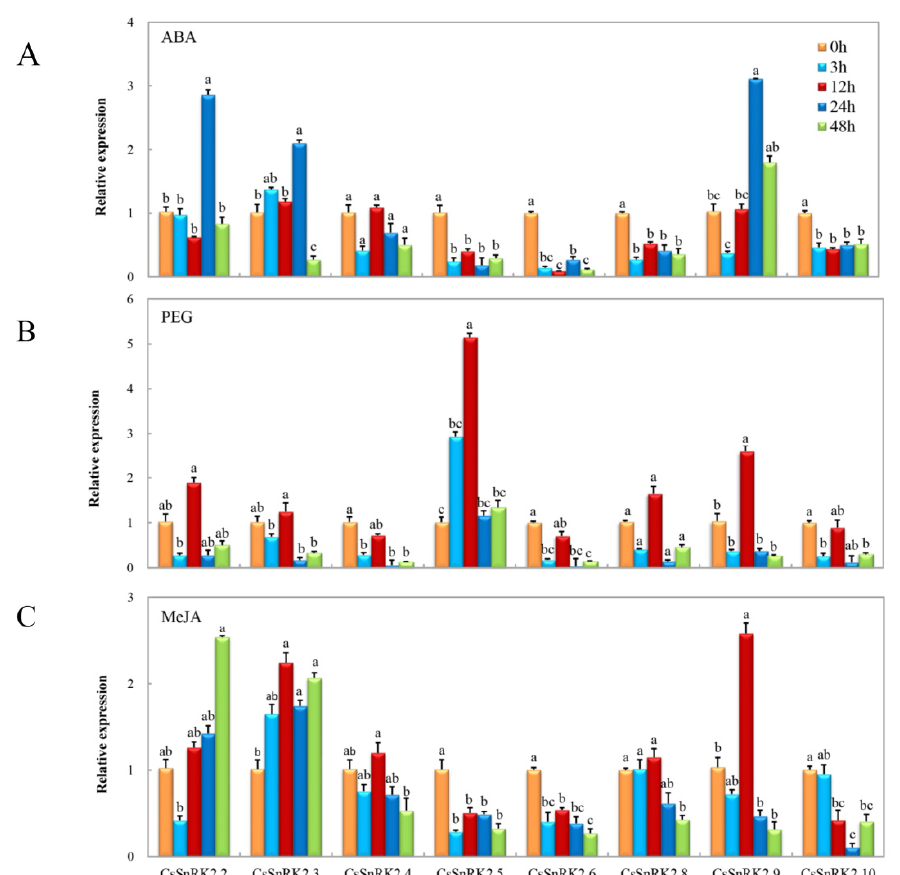
Figure 8. The expression pattern of CsSnRK2 genes in roots treated with ( A ) abscisic acid (ABA), ( B ) PEG and ( C ) methyl jasmonate (MeJA). The sampling time points were 0, 3, 12, 24 and 48 h. Error bars represent the standard error (SE) of three replicates. The relative expression of each gene in different treatment is expressed as mean ± SE ( n = 3). Bars with different lowercase letters were significantly different by Duncan’s multiple range tests ( p < 0.05).